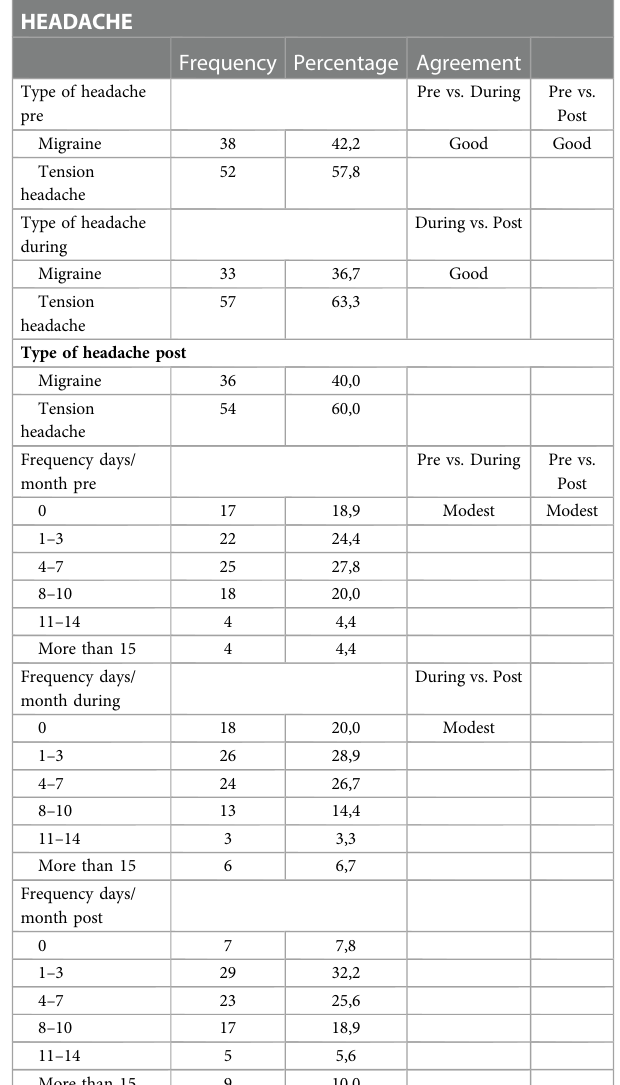
TABLE 4 Concordance analysis about headache